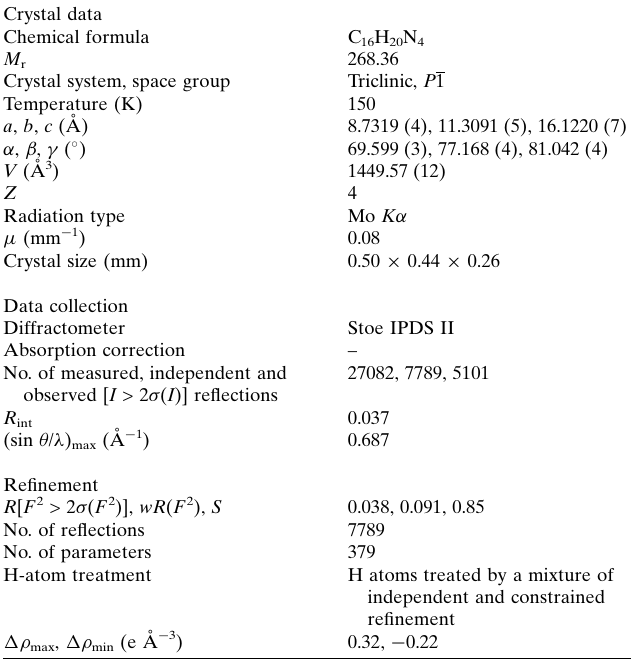
Table 1 Hydrogen-bond geometry (A˚ , (cid:2) ).